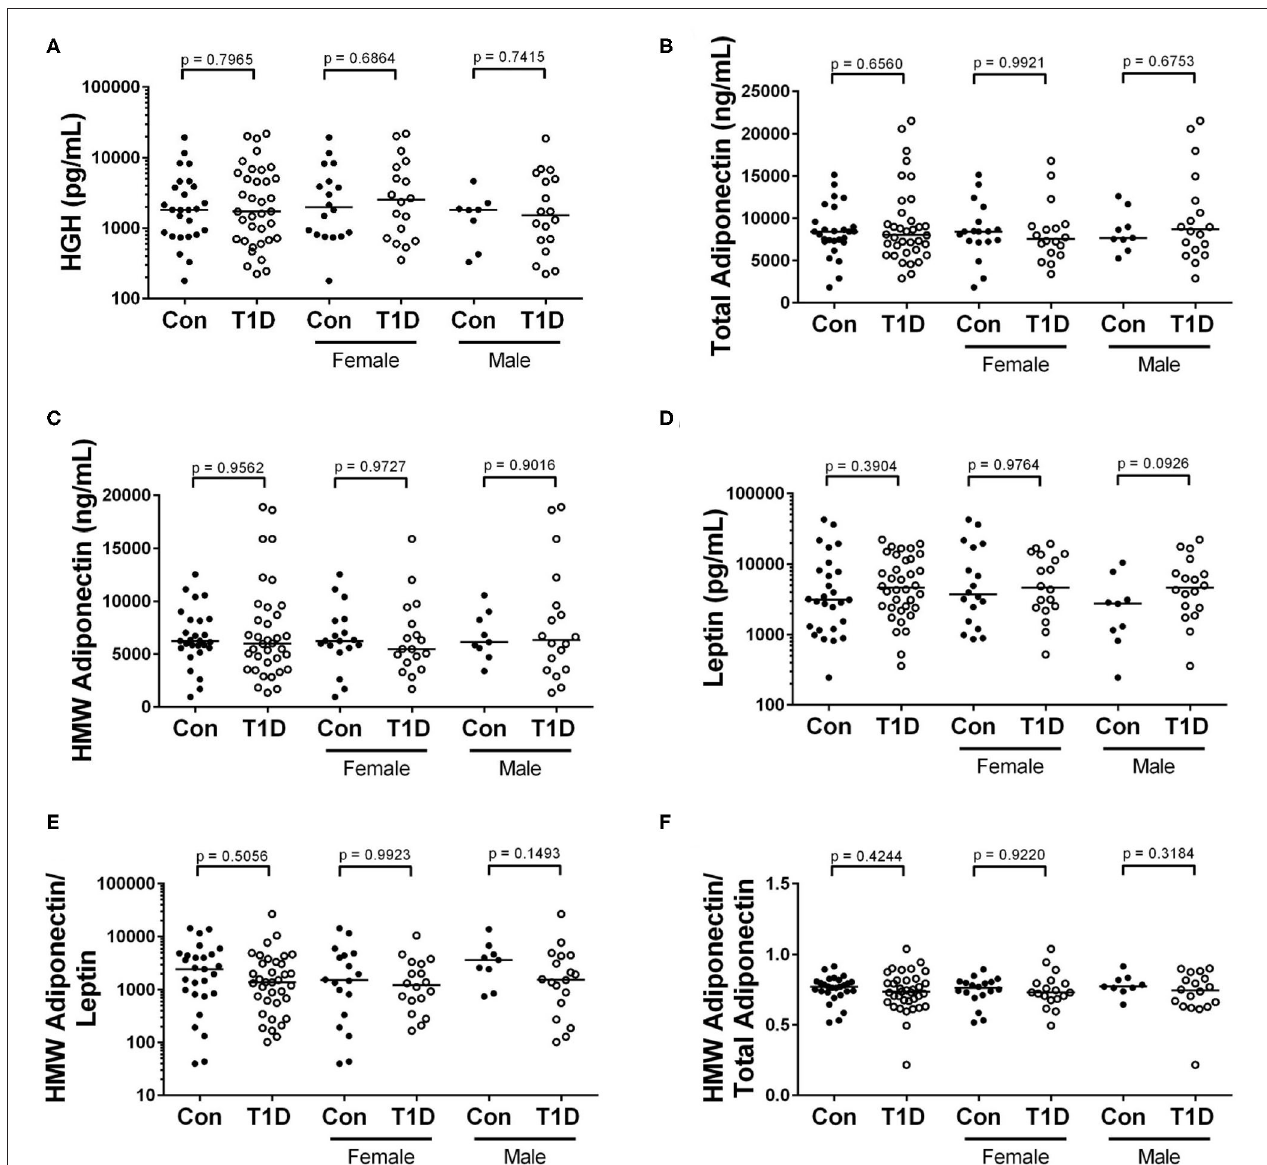
FIGURE 6 | No difference in levels of adipokines and HGH when comparing control and T1D subjects. (A) We found no difference in abundance of human growth hormone (HGH) among T1D subjects and controls. (B–D) Similarly, the levels of total adiponectin, high molecular weight (HMW) adiponectin, and leptin were relatively equivalent when comparing the two groups. (E,F) Finally, the ratios of HMW adiponectin to leptin and HMW adiponectin to total adiponectin were roughly equivalent among the groups. Bars represent